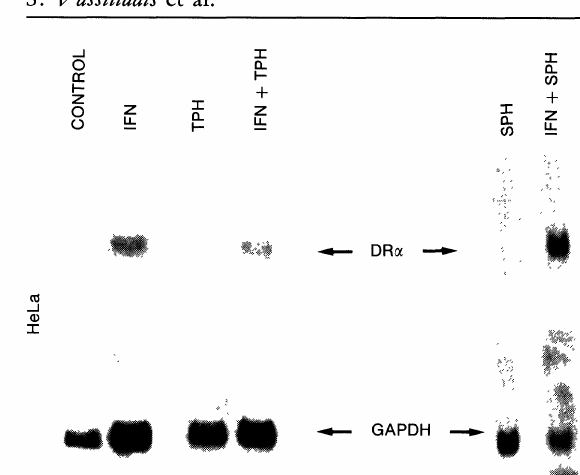
FIG 1. Northern analysis of human HeLa cells showing that class II antigen induction at the mRNA level takes place via the Ca2//Cam pathway after treatment with /-IFN for 48 h. Theophylline (TPH) blocks the expression of HLA-DR, whereas sphingosine (SPH) has no effect. Note that although more RNA (GAPDH quantity control) has been loaded in the FN lane, spectrophotometric analysis has shown that the IFN induction is significant.